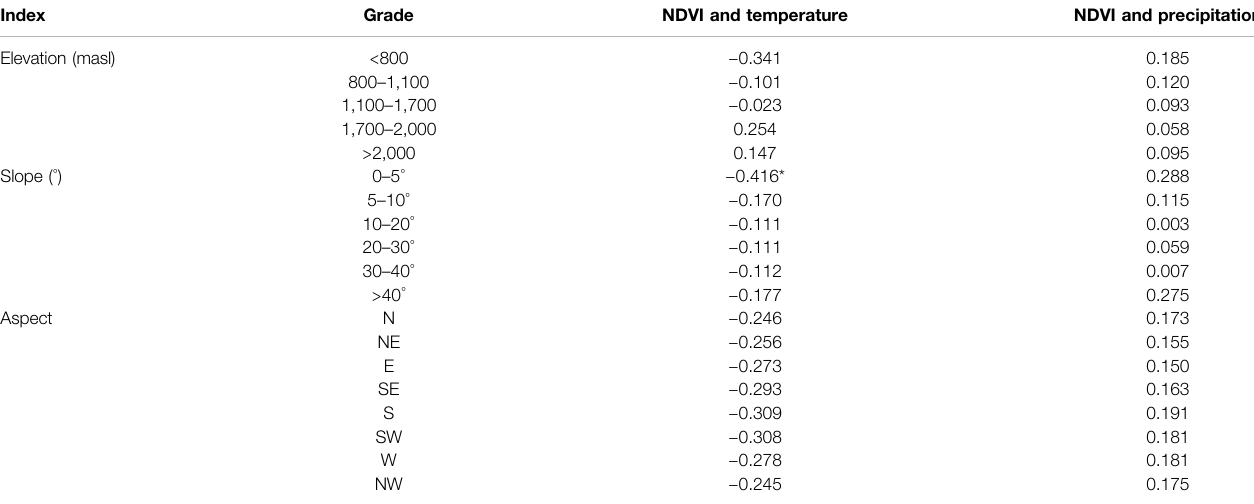
TABLE 1 | Correlation coef fi cients for NDVI with temperature and precipitation at different elevations, slopes, and aspects. Index Grade NDVI and temperature NDVI and